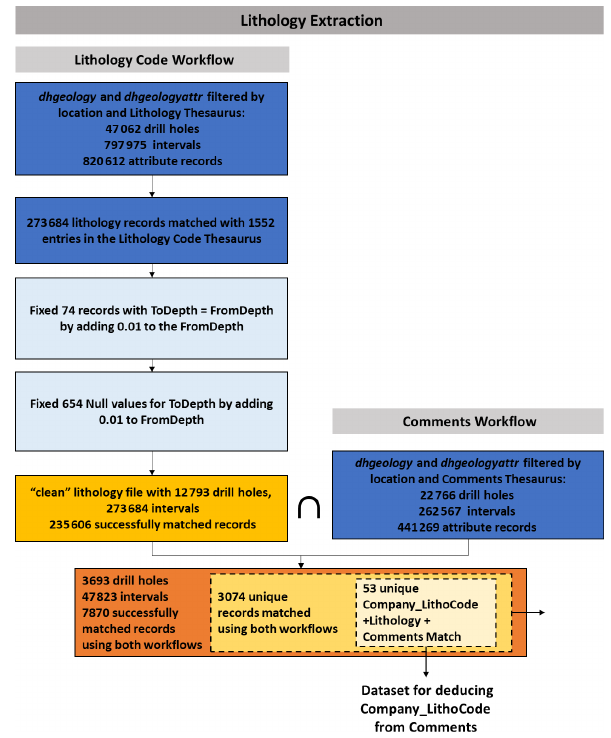
Figure 5. Extraction of lithology data for the YSGB. For the Lithology Code workflow , the extraction starts with filtering the dhgeology and dhgeologyattr table by the location extents and the Drill Hole Lithology Thesaurus. These records are matched with the entries from the Lithology Code Thesaurus. The Lithology Code workflow resulted in 235606 records successfully matched in the fuzzy string matching. The Comments workflow extracts the records from the dhgeology and dhgeologyattr table as well, but this time using the Drill Hole Comments Thesaurus. In to- tal, 47823 records are present in both workflows, 7870 records of which are successfully matched. The 3074 unique entries from this are used as the dataset for the fuzzy string matching assessment.